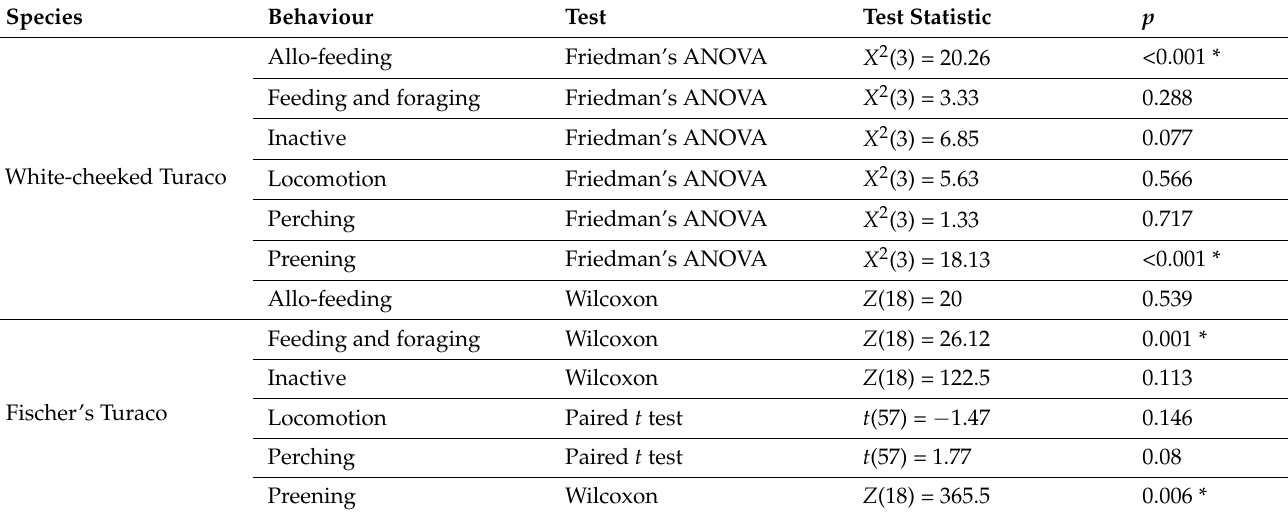
Table 4. Test outputs for comparisons of chopped and whole-food conditions. * indicates significant values ( p < 0.05). Species